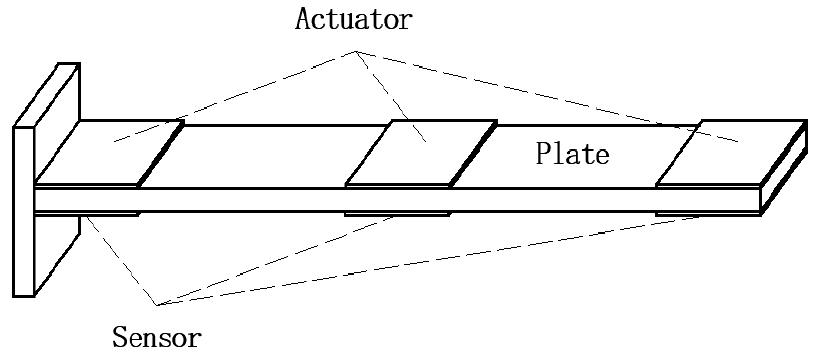
Figure 1. Piezoelectric active control of cantilever